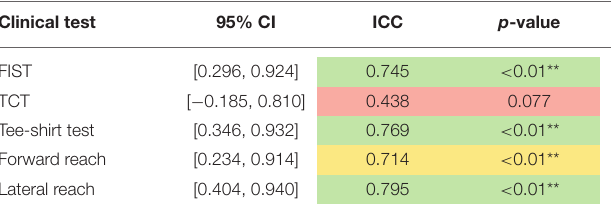
TABLE 3 | Interclass correlations (ICC) between clinical test outcomes during session 1 and session 2. Clinical